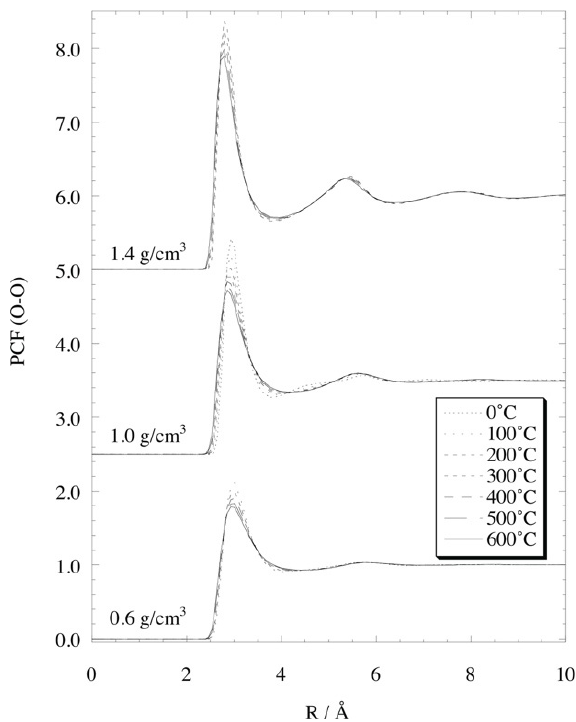
Figure 11. Temperature dependence of O–O pair correlation functions of liquid water at different densities. The temperature varies from 0 to 600 °C at 1.0 g cm − 3 , whereas it ranges from 200 to 600 °C at 0.6 and 1.4 g cm − 3 . This figure is reprinted with permission from JCP , 1999 , 111 , 8545. Copyright 1999 AIP Publishing.